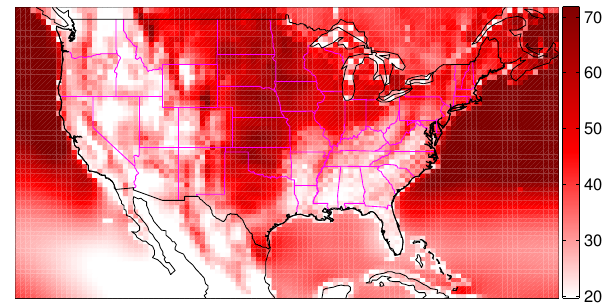
Fig. 11. Difference mean WPD between 80m and 50m (W m − 2 ).